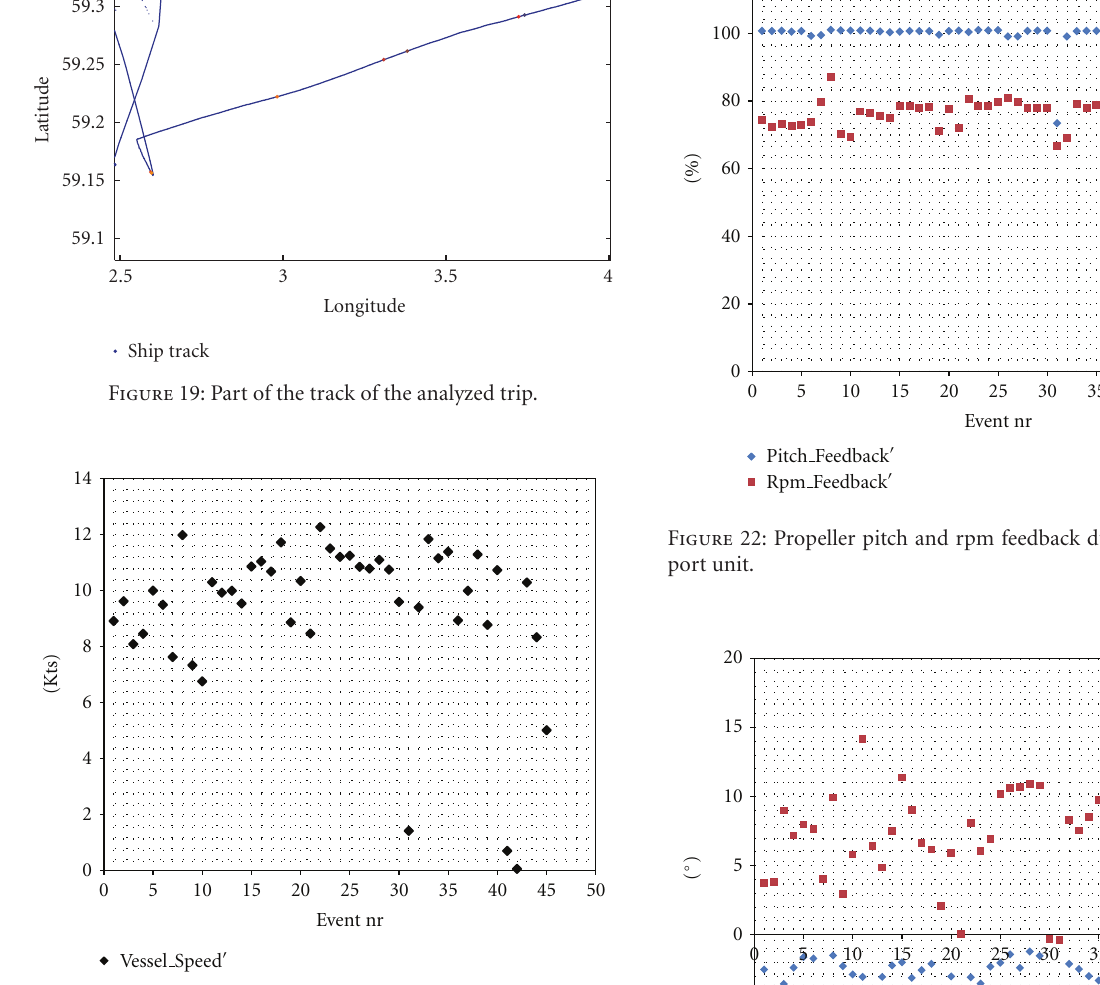
Figure 20: Vessel speed during the events—port unit.